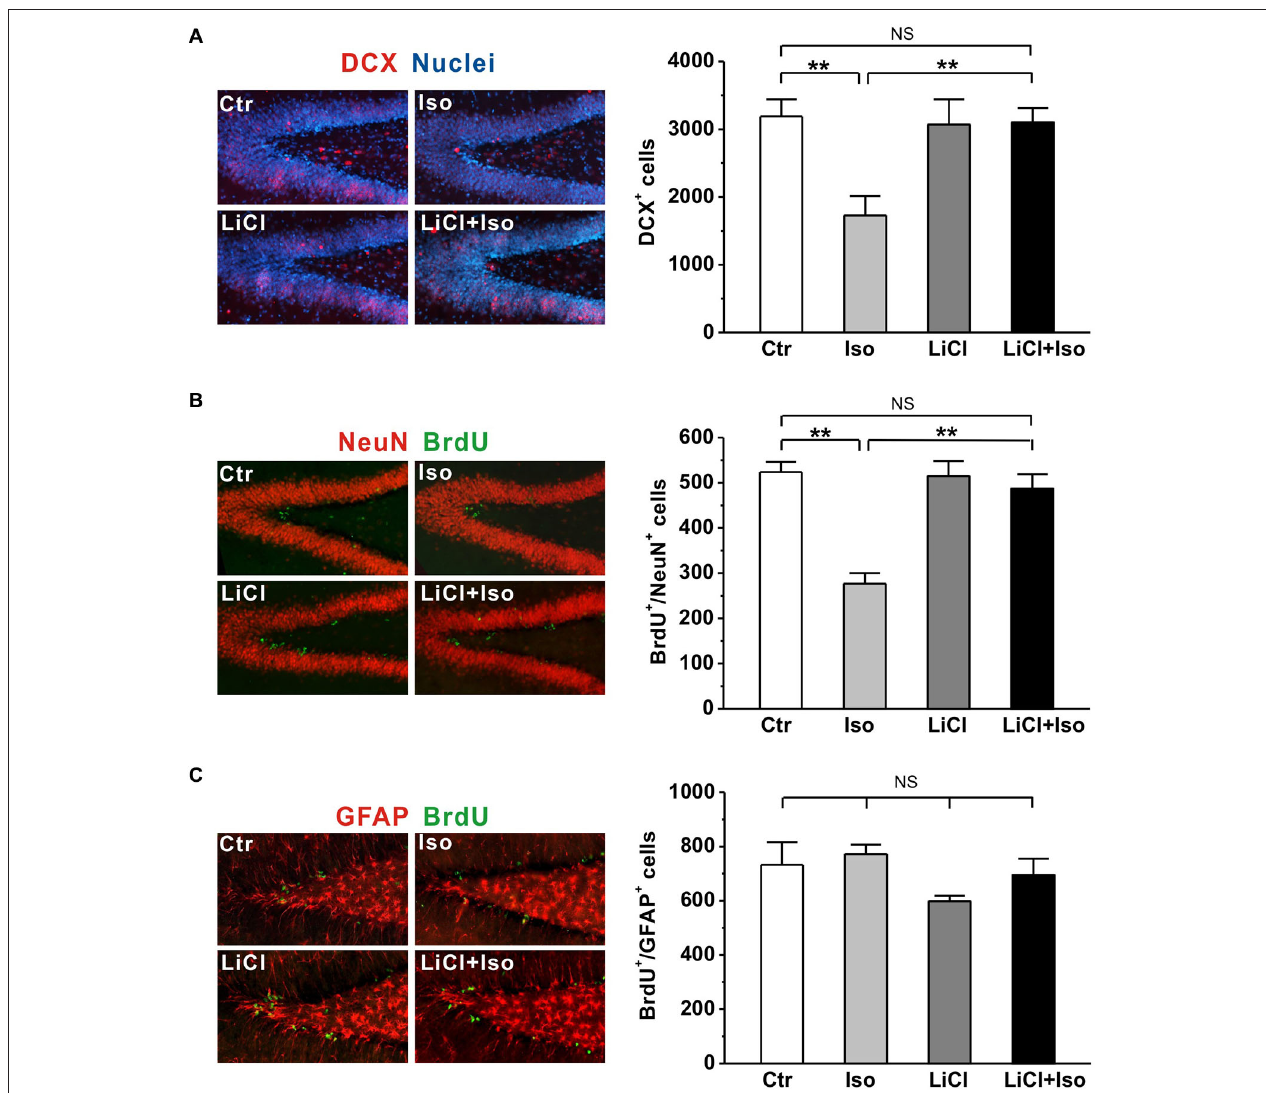
newborn astrocytic phenotype cells (right bar) in the DG. Two-way ANOVA analysis was used in this experiment. For DCX + newborn neurons: treatment × drug, F ( 1,20 ) = 6.708, P < 0.05; treatment, F ( 1,20 ) = 6.179, P < 0.05; drug, F ( 1,20 ) = 4.737, P < 0.05. For BrdU + /NeuN + : treatment × drug, F ( 1,20 ) = 15.314, P < 0.05; treatment, F ( 1,20 ) = 24.147, P < 0.05; drug, F ( 1,20 ) = 12.900, P < 0.05. For BrdU + /GFAP + : treatment × drug, F ( 1,20 ) = 0.280, P > 0.05; treatment, F ( 1,20 ) = 1.541, P > 0.05; drug, F ( 1,20 ) = 3.744, P > 0.05. Data show mean ± SEM (* p < 0.05; ** p <